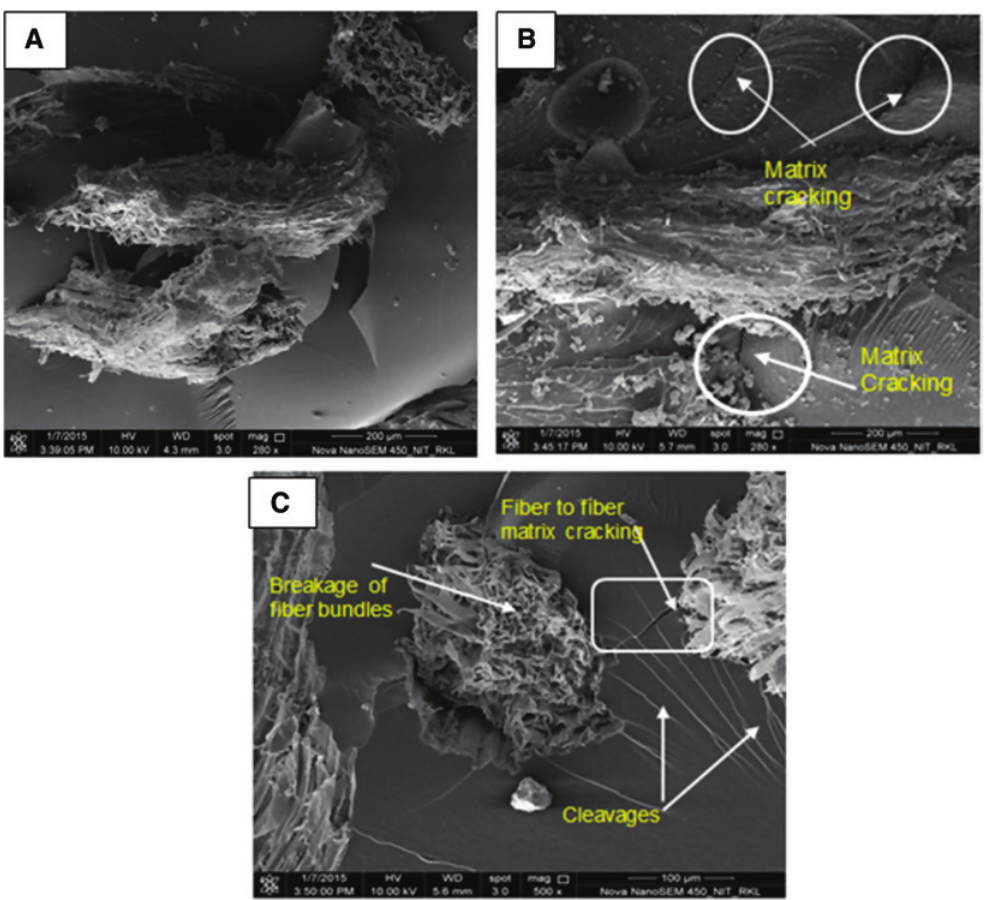
Figure 9: Fracture surface of the alkali-treated LCF epoxy composite subjected to (A) distilled water, (B) saline water, and (C) subzero